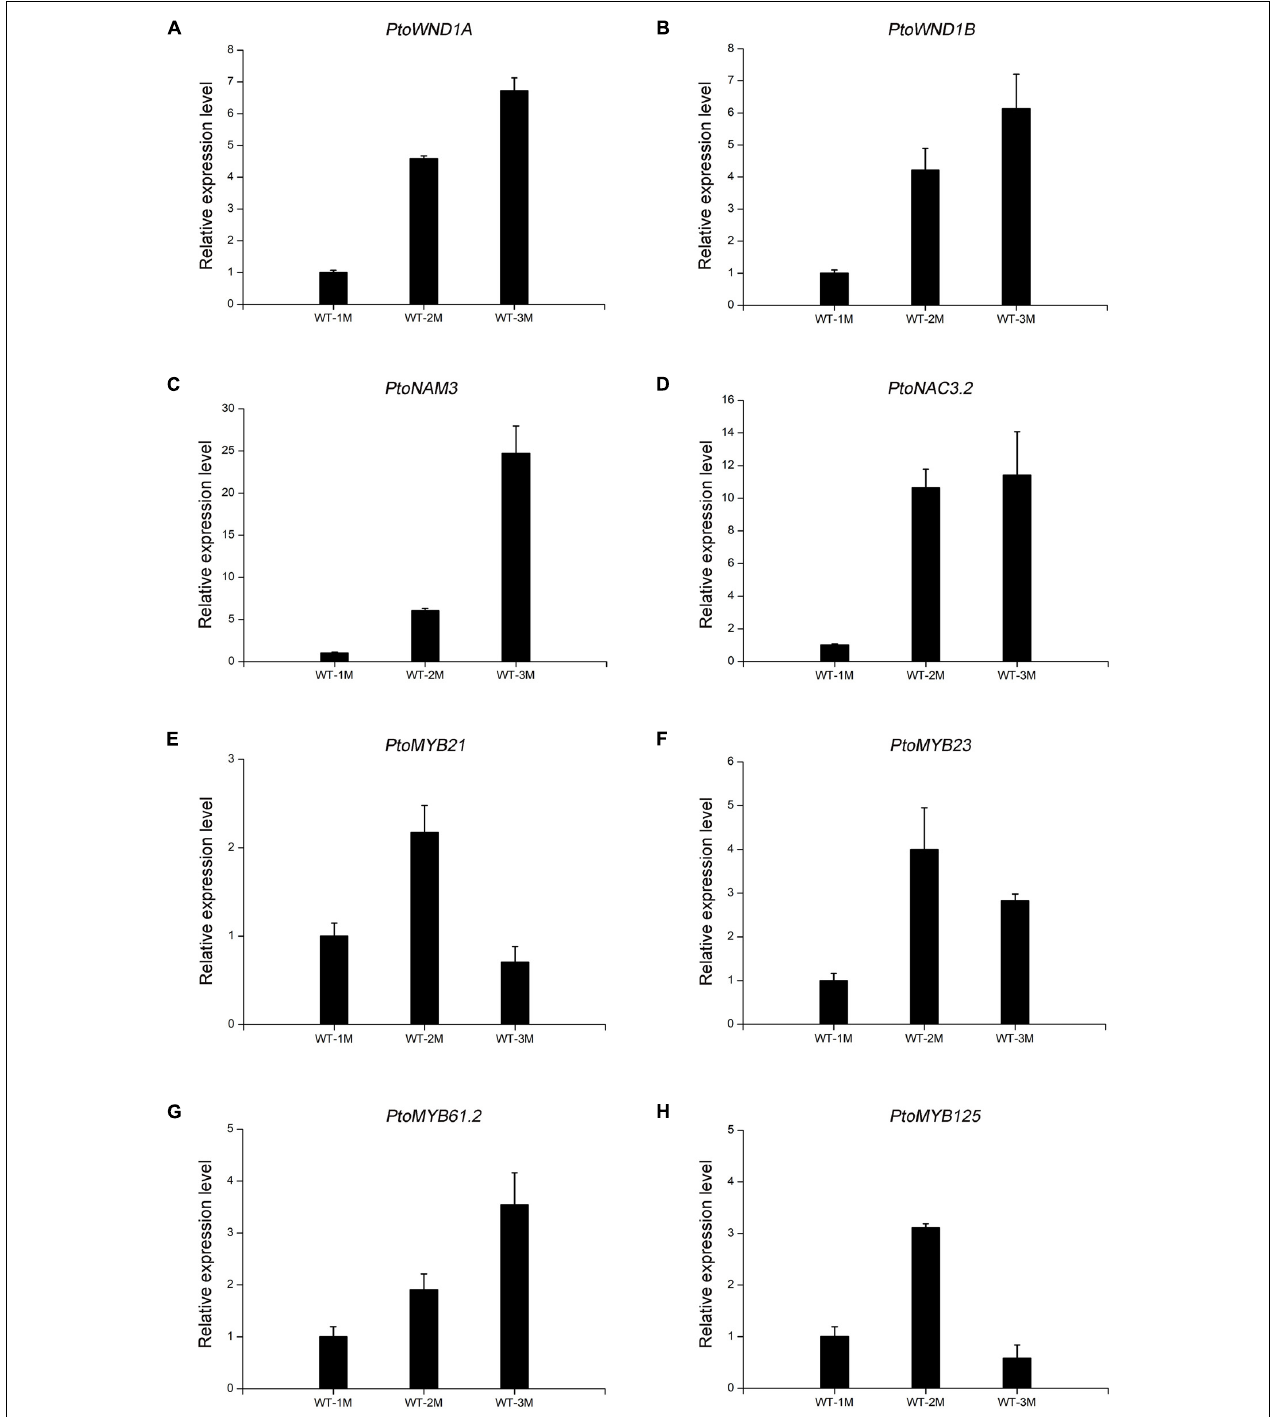
FIGURE 5 | The expression levels of TFs involved in xylem development by qRT-PCR in WT-1M, WT-2M, and WT-3M plants (A–H) . The expression levels of PtoWND1A, PtoWND1B, PtoNAM3, PtoNAC3.2, PtoMYB21, PtoMYB23, PtoMYB61.2, and PtoMYB125 , respectively. The expression was normalized to the actin gene. Relative expression levels of candidate genes were calculated by the 2 − (cid:49)(cid:49) Ct method. All values shown are means ± SD ( n = 3). significantly different expression levels (fold change ≥ 2 or ≤ – be detected in the transcriptome. Metabolic process and cellular 0.5, and corrected P -value < 0.05) in at least one of the three process in “Biological process”; cell, cell part, membrane and time points ( Figure 6A ). These differential proteins could all organelle related genes in “Cellular component”; and binding